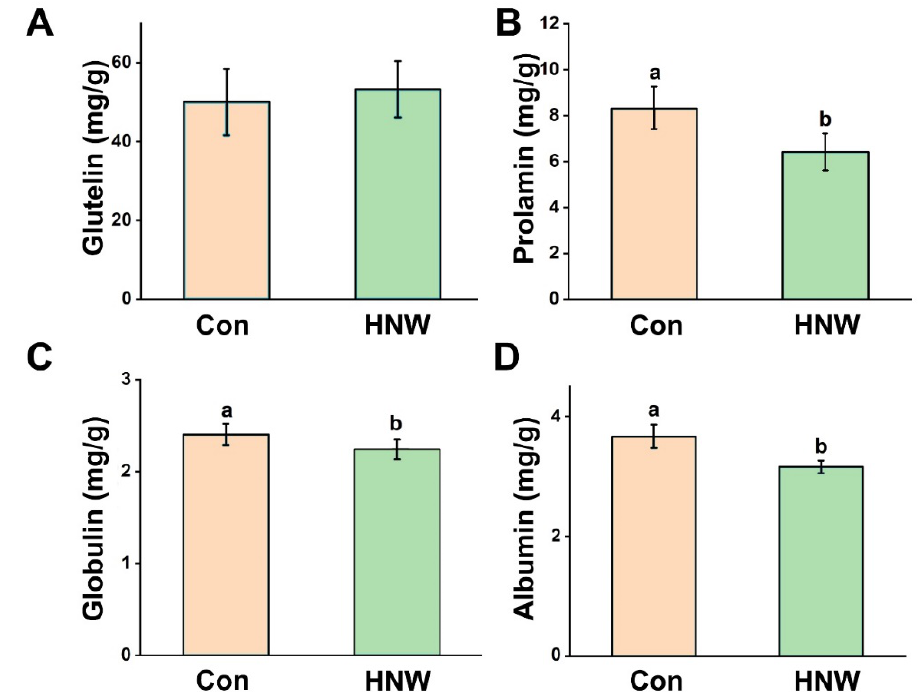
Figure 6. Changes of gene expression in leaves at the filling stage (5 September 2020) showing that HNW might decrease amylose accumulation. Transcripts of GBSS1 , ISA1 , SBE1 , and SBE2 were analyzed by qPCR. Data are mean ± SD (n = 3).